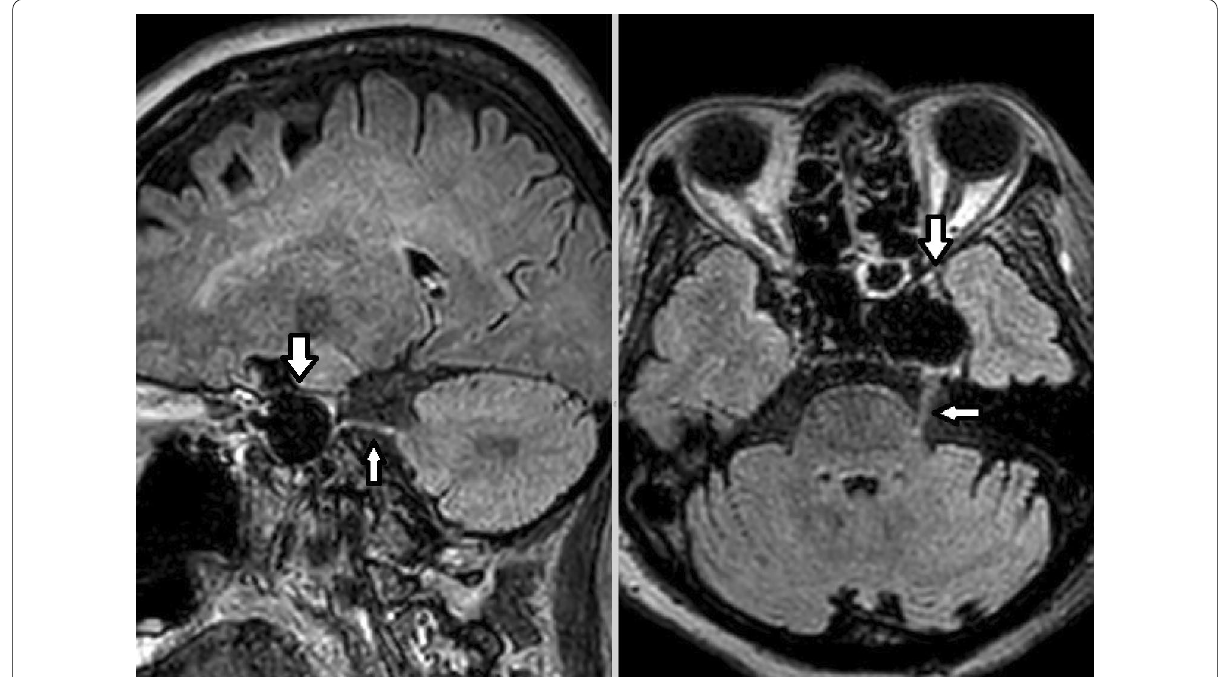
Fig. 1 3D-FLAIR in axial and sagittal showed a giant aneurysm (hypointense, big arrow) located at the left cavernous sinus inducing mass effect to the left Meckel’s cave. The hyperintense left trigeminal nerve (small arrow) is impinged by the aneurysm within the left Meckel’s cave, causing trigeminal